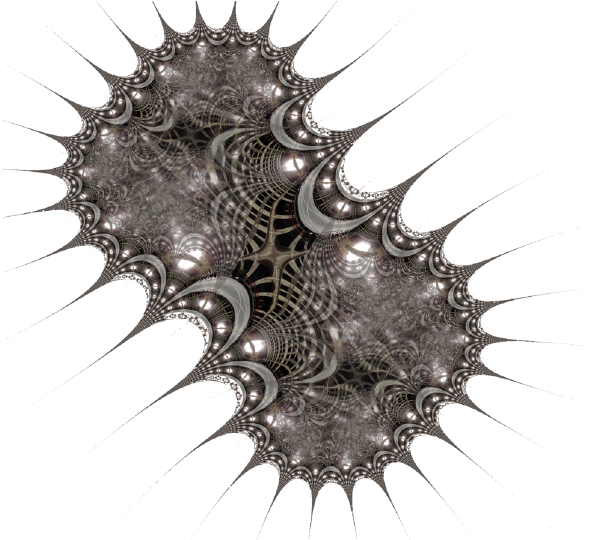
Figure 10 | “Urban Caterpillar”.